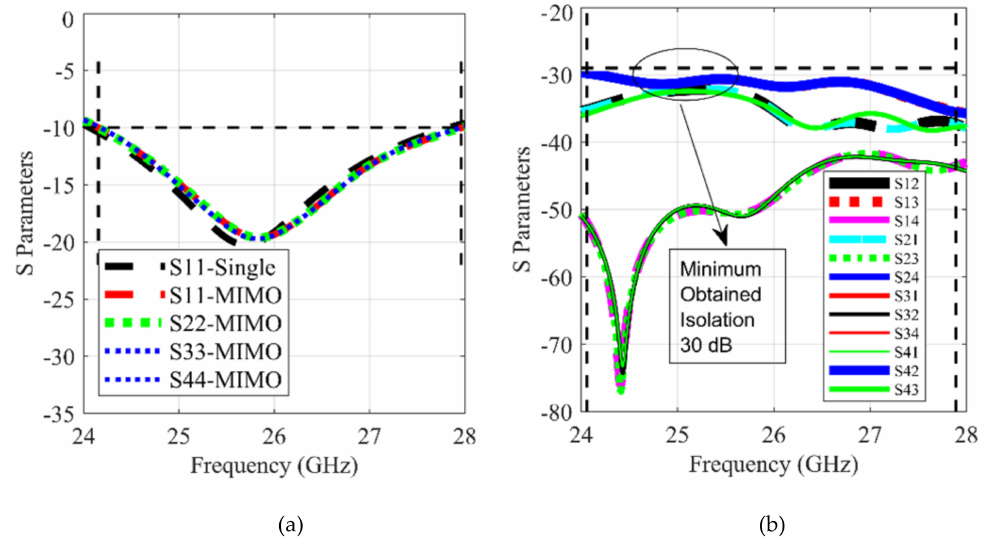
Figure 6. Scattering parameters for the high-band (mmWave) antenna design: ( a ) reflection; ( b )